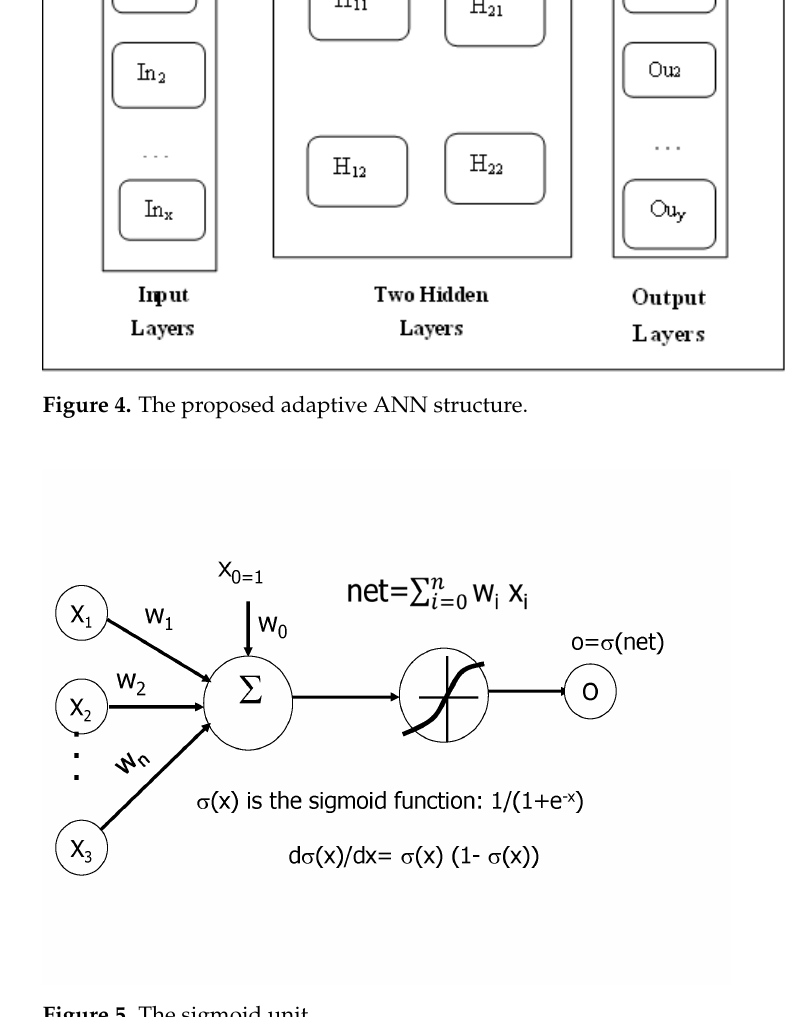
Figure 5. The sigmoid